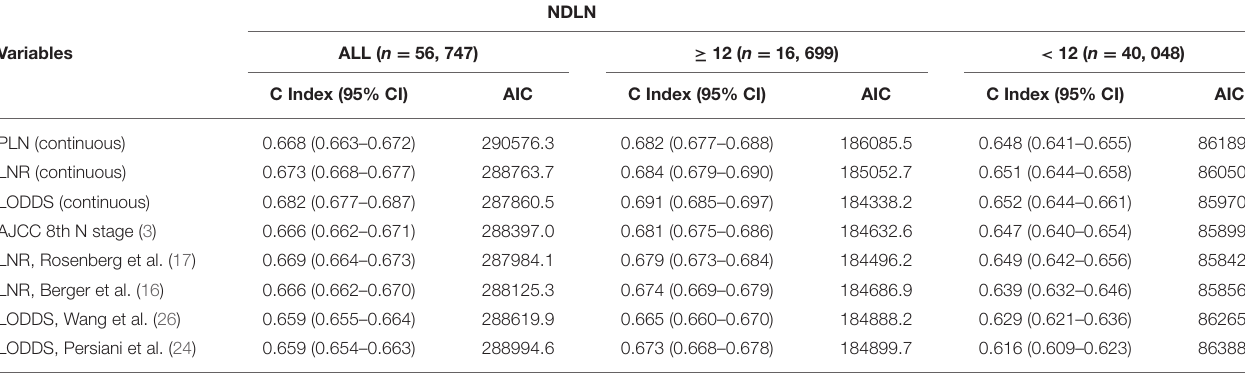
TABLE 4 | Prognostic performance of different lymph node staging systems before and after stratifying for NDLN.